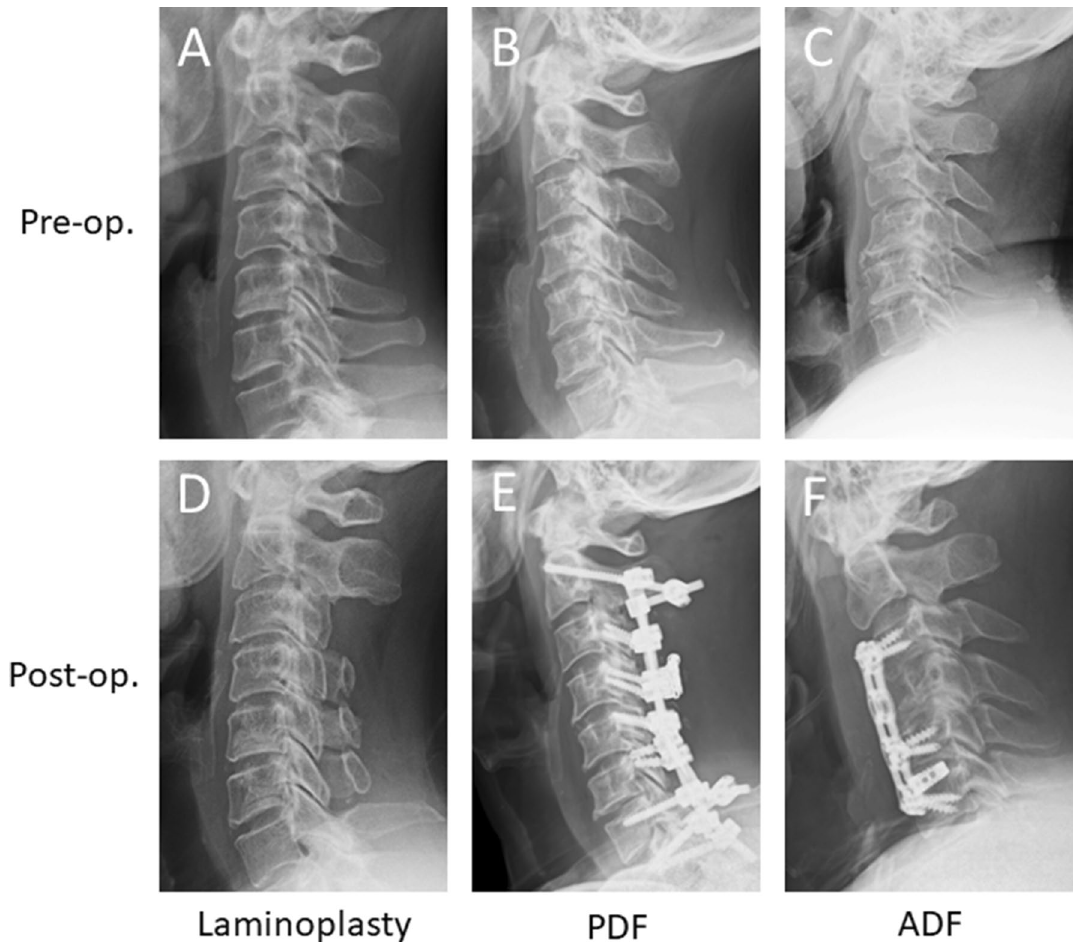
Figure 2. Representative images of each surgical procedures. Laminoplasty included open-door method and double-door method. There is no significant difference in any postoperative assessment between both procedures. Preoperative ( A ) and postoperative ( D ) radiograms of the OPLL patient received laminoplasty. Posterior recompression with instrumented fusion (PDF) was performed as combinatory procedure of laminoplasty or laminectomy followed by instrumented posterior fusion. Preoperative ( B ) and postoperative ( E ) radiograms of the OPLL patient received PDF. Anterior decompression with fusion (ADF) was performed as subtotal corpectomy with extirpation or floating of ossification foci followed by autologous bone graft with anterior plating. Preoperative ( C ) and postoperative ( F ) radiograms of the OPLL patient received